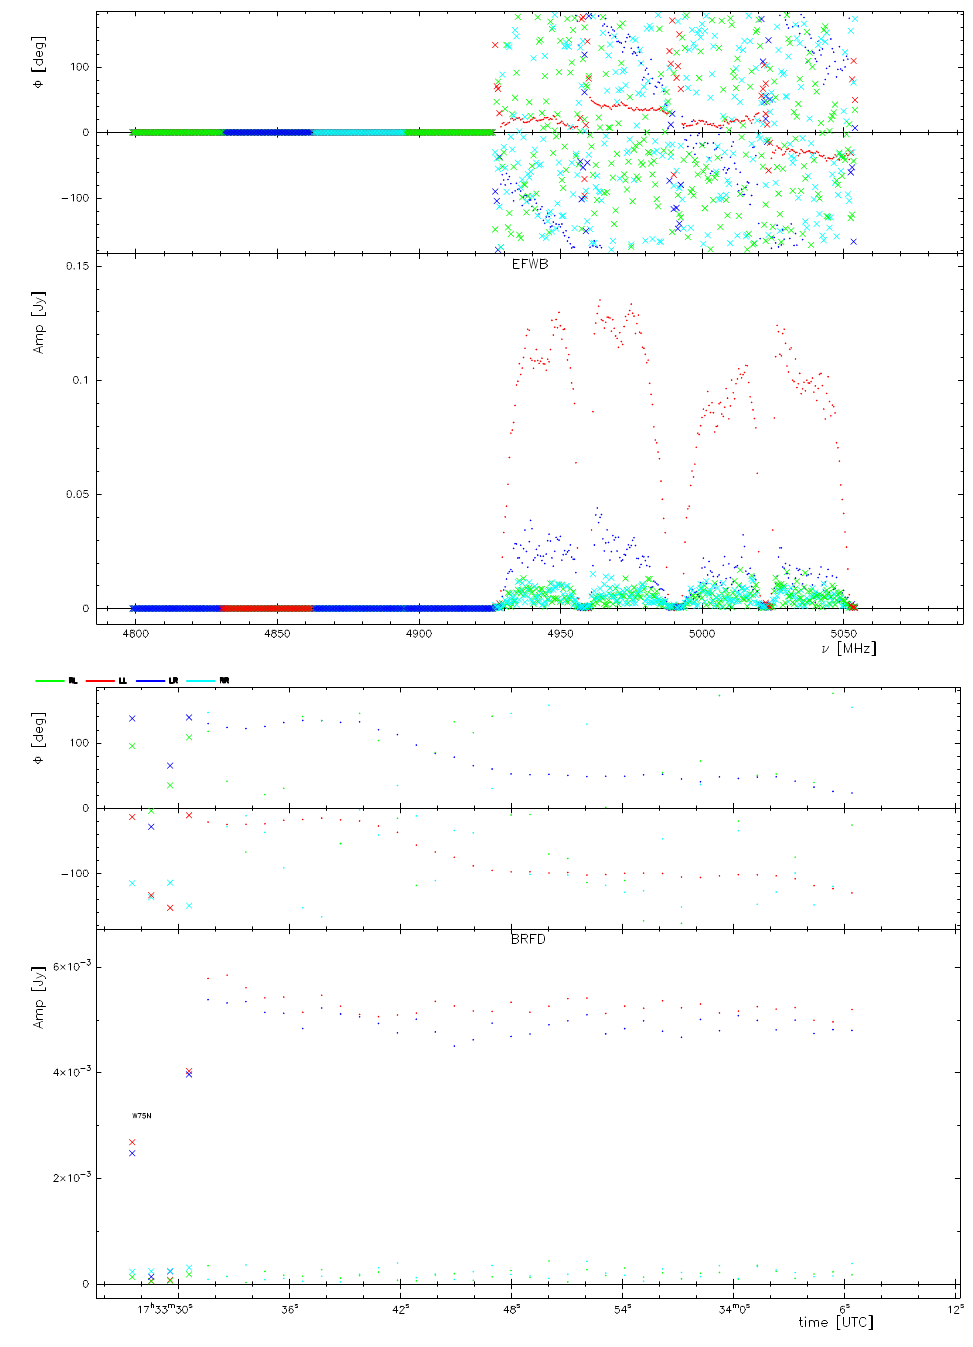
Figure A1. Examples of flagged bad data indicated with crosses. These plots are produced automati- cally with jiveplot (Available online: https://github.com/haavee/jiveplot, accessed on 30 July 2022) by rPICARD and show visibility amplitudes and phases per baseline and per scan, color-coded by polarization. Top : Scan-averaged EVN data on the Effelsberg–Westerbork baseline. The Effelsberg RCP channel and first four spectral windows contain no signal and have been flagged. Bottom : Frequency-averaged VLBA data on the Brewster–Hancock baseline. Brewster has been a few seconds late on source, resulting in bad phases and amplitudes at the start of the